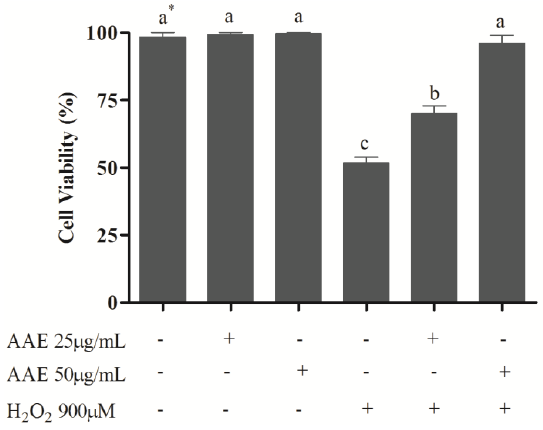
Figure 2. Cell viability of human lung fibroblast cells (MRC5). MRC5 cells were